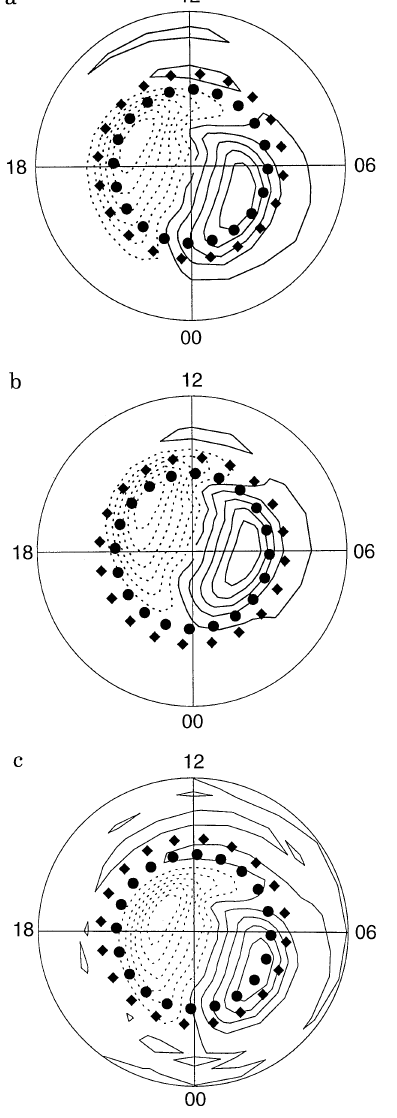
Fig. 1a (cid:177) c. Rich and Maynard (1989) statistical convection patterns for Kp " 4o on a magnetic latitude vs. MLT grid. a Default pattern used in RUN-DEF and RUN-1; the cross-cap potential drop is 82 kV. b RUN-2 convection pattern shifted slightly towards the day; the cross-cap potential drop is 65 kV. c RUN-3 convection pattern shifted slightly towards the morning; the cross-cap potential drop is 65 kV. The diamonds and circles represent the position of 68 ° N, 18 ° E and 72 ° N, 18 ° E geographic, respectively, in corrected geomagnetic coordinates. The perimeter latitude is 50 ° N